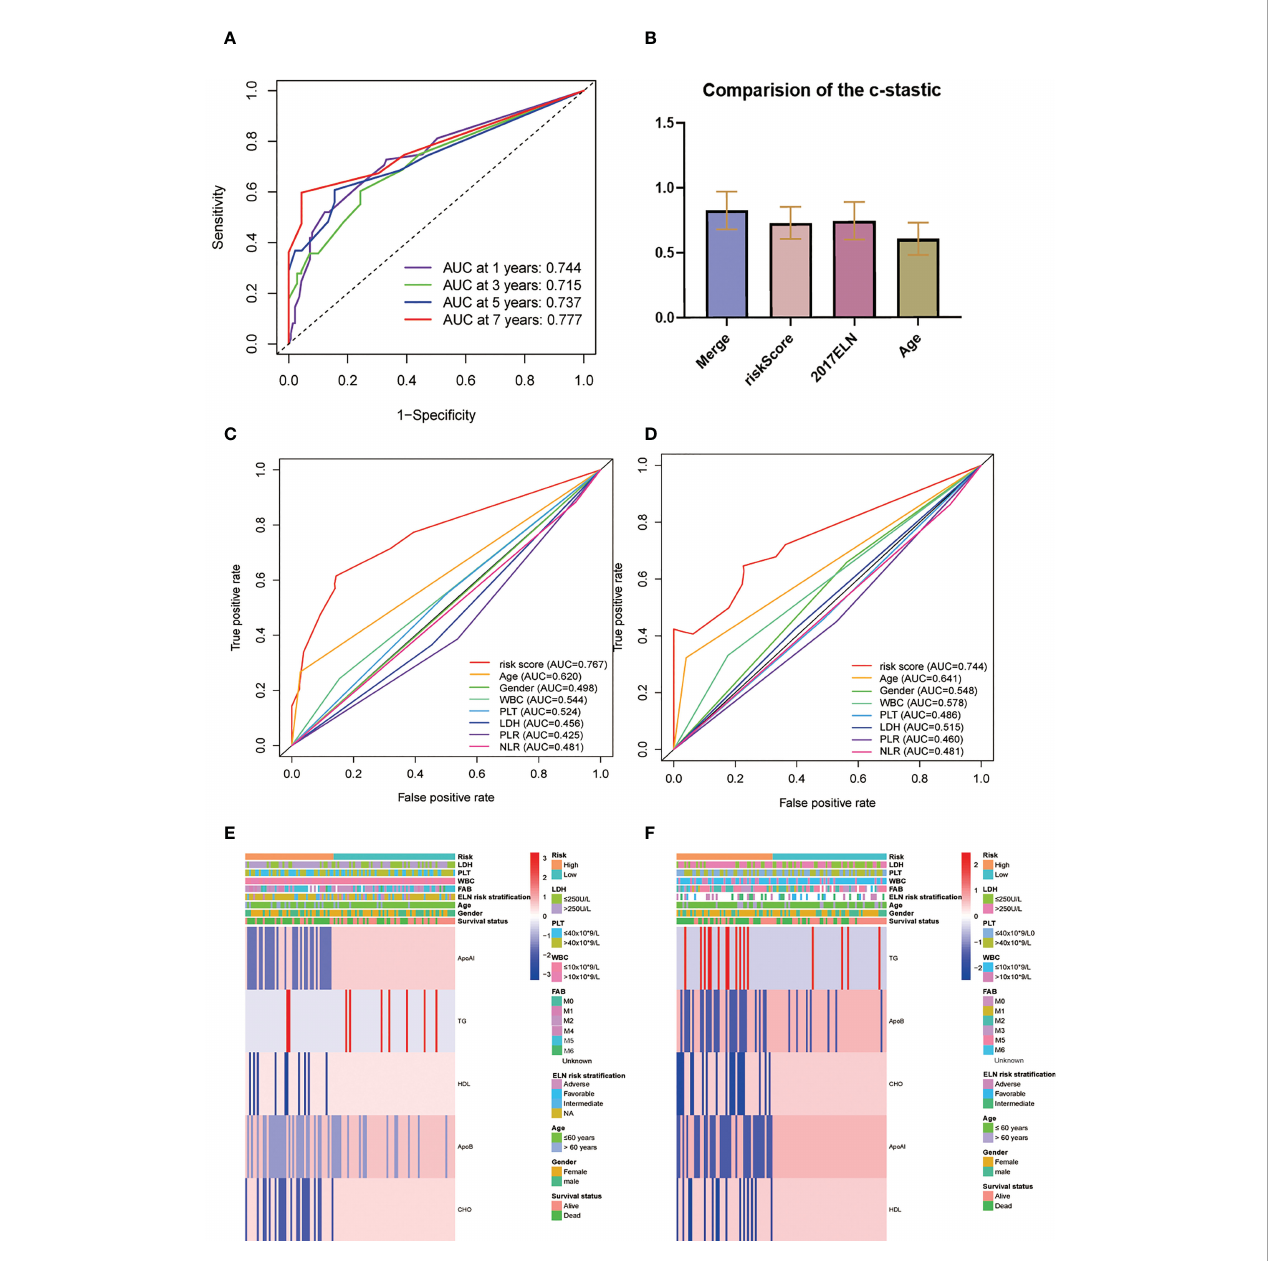
FIGURE 5 (A) Time-dependent ROC analysis for one-, three-, fi ve-, and seven-year OS for the lipid prognostic model. (B) C-indices were compared by combining the lipid prognostic model with the 2017 ELN cytogenetic risk classi fi cation and others. A higher C-index indicates greater precision in prediction. (C, D) AUCs of the fi ve-year risk score model in the training (C) and validation (D) cohorts were signi fi cantly different from other clinical indicators. (E, F) Heatmap of the fi ve-lipid prognostic factor and other clinicopathological characteristics in different risk scores for the training (E) and the validation (F)